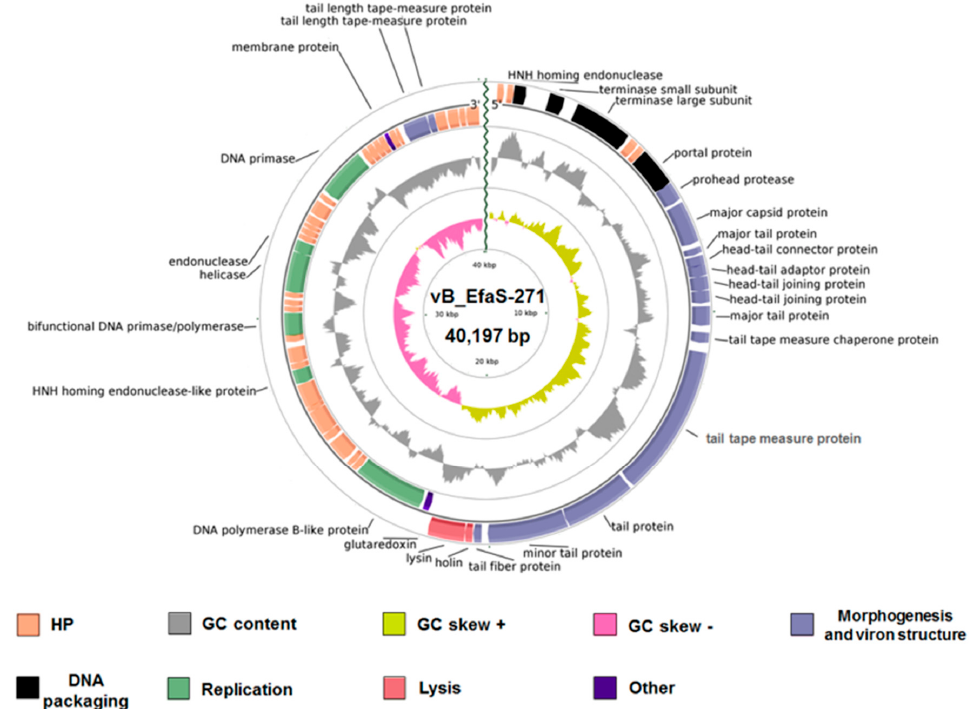
Figure 2. Circular map of the bacteriophage vB_EfaS-271 genome created using the BRIG platform. The innermost circle indicates GC content, where yellow and pink correspond to positive and negative GC skews, respectively. The gray ring shows the GC content. The ORFs with predicted functions are categorized into five groups: phage structure and morphogenesis (blue arrows), host lysis (red arrows), phage DNA replication (green arrows) and DNA packaging (black arrows) and others (dark blue arrows). For clarity, the hypothetical proteins (HP) are marked with orange arrows but not described on the map.